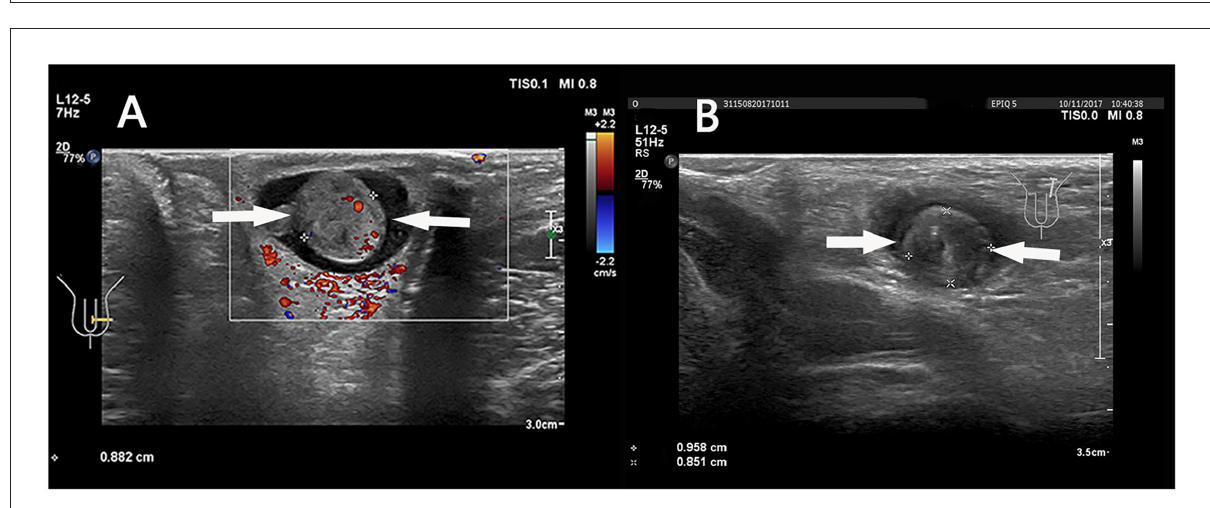
FIGURE7 (A) A 6 years 4-month-old boy with a first episode of acute left scrotal pain for 2 days. (B) An 8 years 5-month-old boy with a first episode of acute left scrotal pain for 15h. (A,B) The “whirlpool sign” in spermatic cord